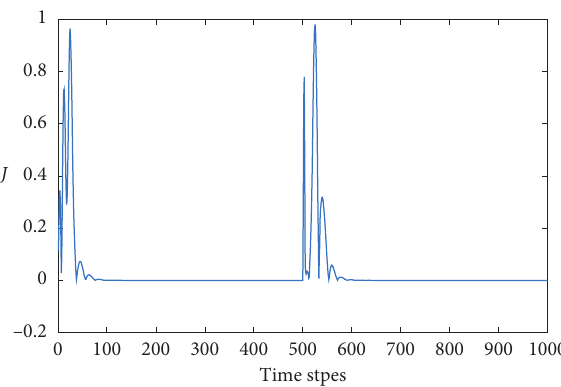
Figure 10: Estimated cost function J